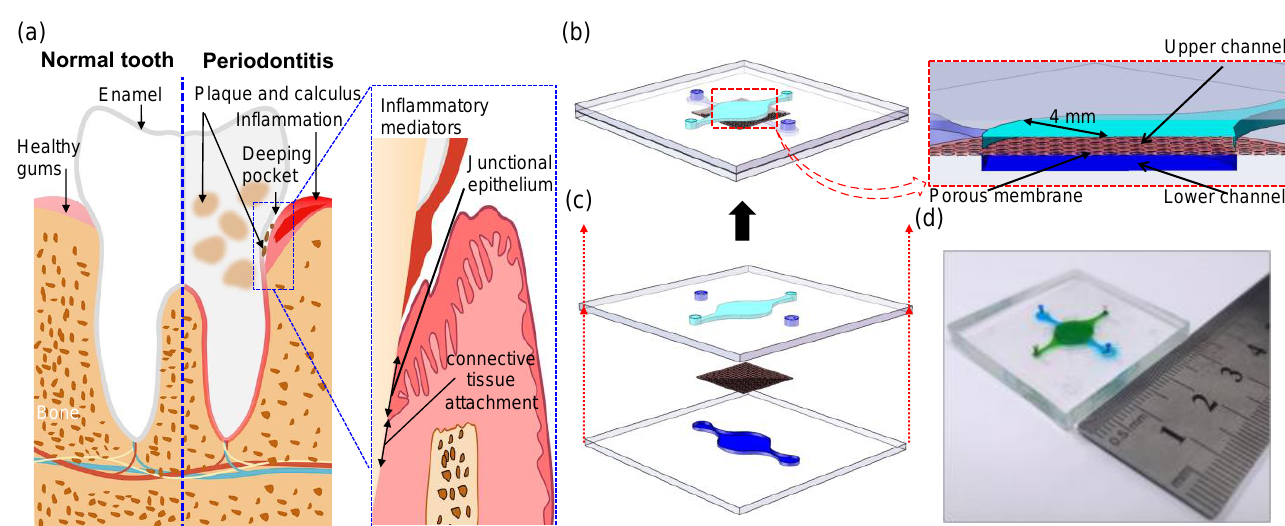
Figure 4. Structure and design of the developed epithelium–capillary interface-on-a-chip. ( a ) Victory anatomy of periodontal tissue; ( b ) the fully fabricated periodontal soft tissue chip, the system comprises two perpendicular flow channels: channel heights are 200 μm, and chambers radium are 4 mm (lumen and albumen); ( c ) the chip consists of two PDMS layers, and a piece of polycarbonate membrane; ( d ) close-up view. Channels model the lumenal (green) and ablumenal (blue) sides of the epithelium unit. HGEC and HUVEC cells are cultured on the lumenal and ablumenal sides of the enclosed porous membrane, respectively.